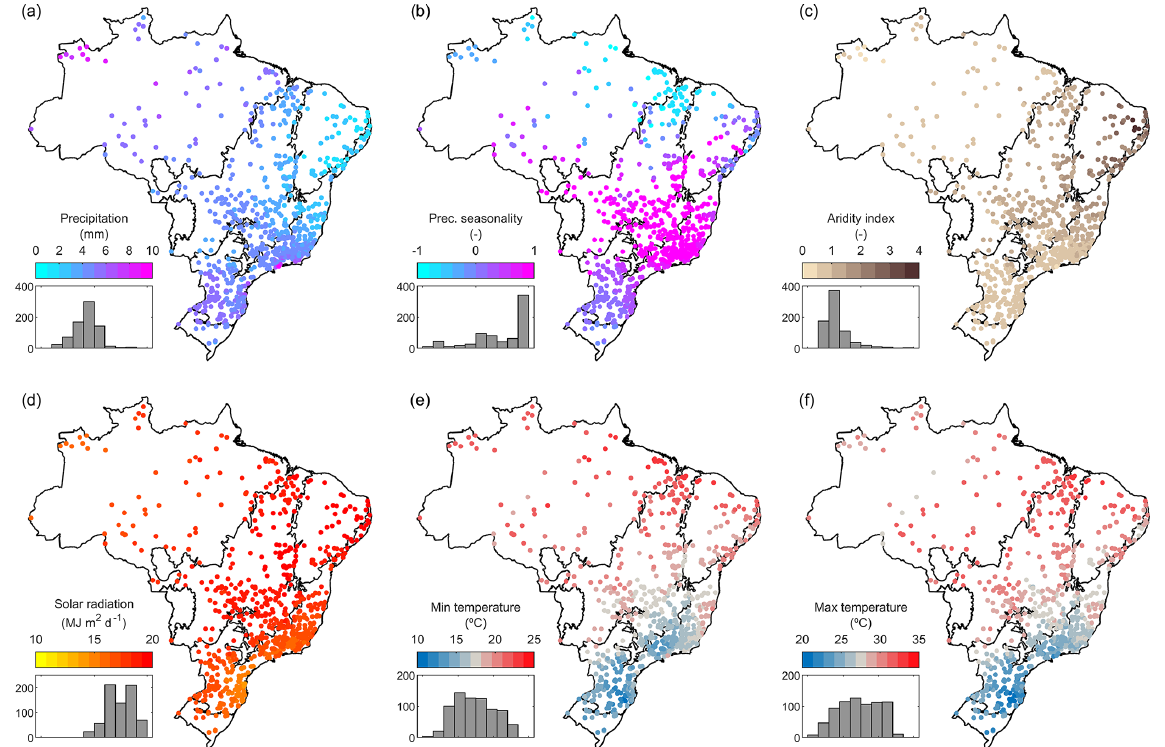
Figure 4. Spatial distribution of climate indices of the CABra catchments. (a) Mean daily precipitation (in mmd − 1 ); (b) precipitation seasonality (dimensionless); (c) aridity index (dimensionless); (d) mean daily solar radiation (in MJm 2 d − 1 ); (e) mean daily minimum temperature (in ◦ C); (f) mean daily maximum temperature (in ◦ C).